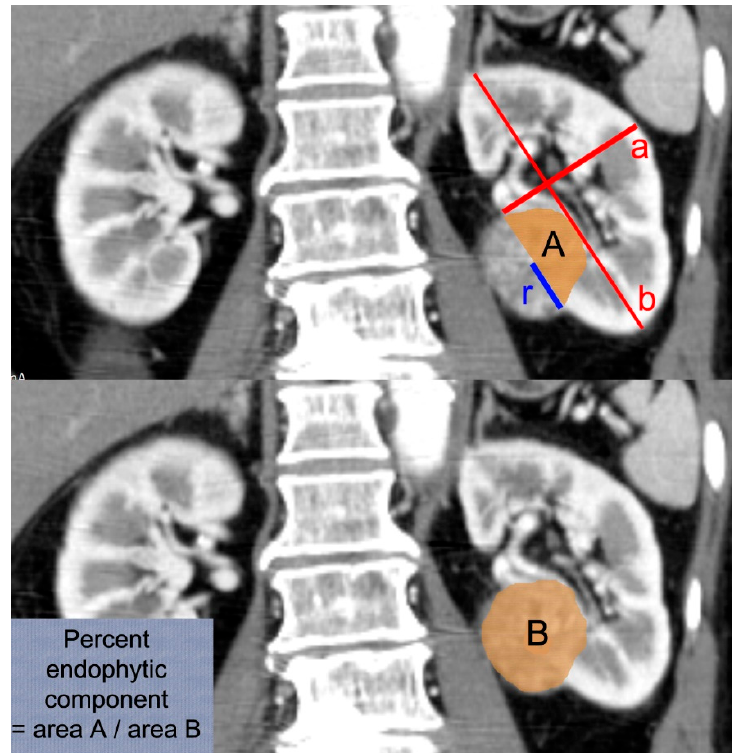
Figure 2. Measurements of the study. Kidney volume was estimated as cylindrical volume using the short ( a ) and long diameter ( b ) of the kidney on the three-dimensional computerized tomography (CT) image. The tumor volume was estimated as a ball with its radius of maximal tumor radius (r). Percent endophytic component was measured as a percentage ratio of endophytic tumor area ( A ) to whole tumor area ( B ) on the CT image where the maximal tumor area was observed.